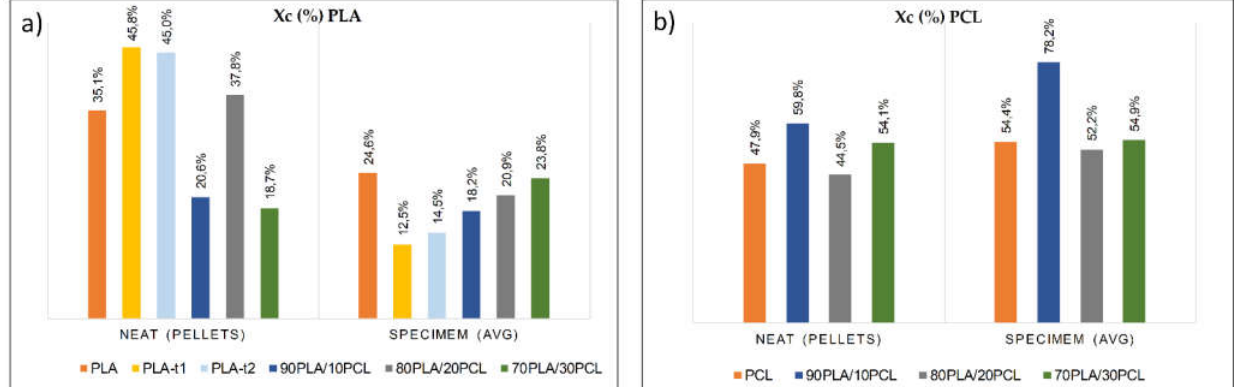
Figure 5. Crystallinity changes: ( a ) X cPLA and ( b ) X cPCL .